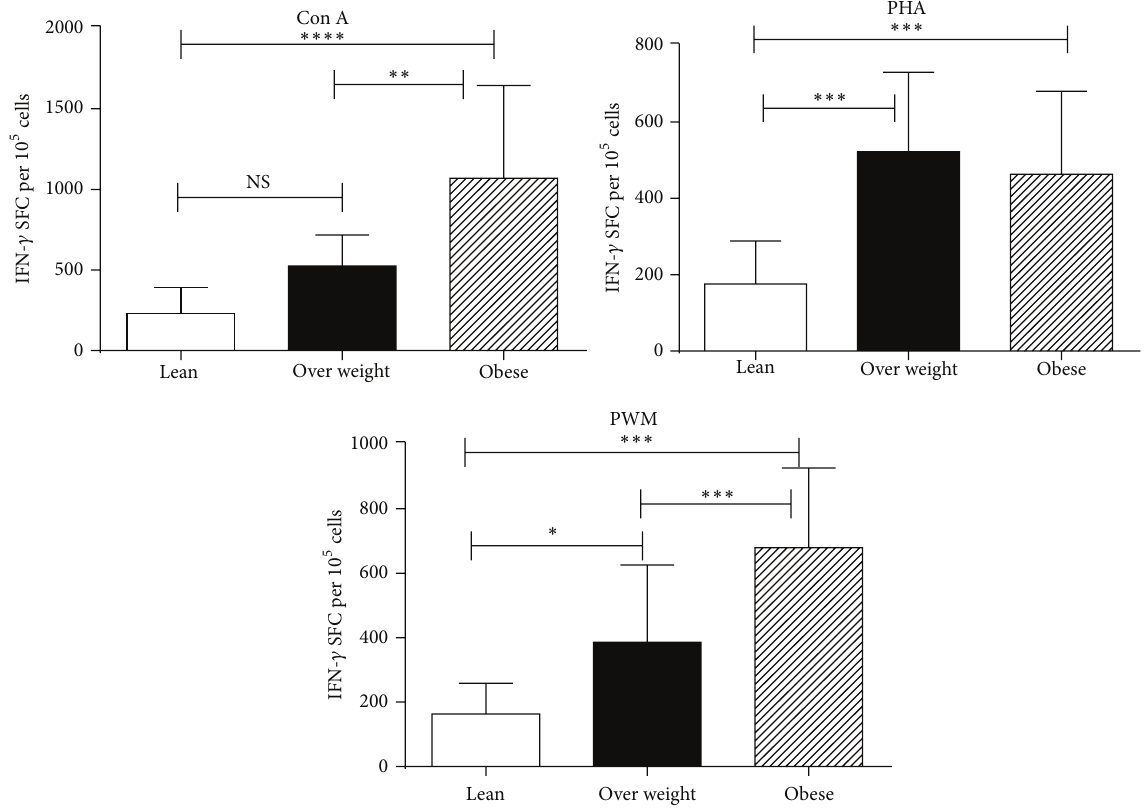
Figure 4: IFN- 𝛾 Elispot response to mitogens in lean, overweight, and obese chimpanzees. PBMCs isolated from the blood samples of the chimpanzees. Triplicate wells of the 96-well microtiter plates, precoated with IFN- 𝛾 antibody, were seeded with 10 5 PBMCs from the monkeys and incubated with 5 𝜇 g of each of the mitogens for 36 h at 37 ∘ C. At the end of the incubation period, the wells were washed and stained with biotinylated second IFN- 𝛾 antibody. The total number of spot forming cells in each of the mitogen-stimulated wells was counted and adjusted to control medium as background. See method section for experiment details. The results shown are an average of two distinct experiments and comparison between groups of chimpanzees was done by one-way analysis of variance with the Kruskal-Wallis test as described in Figure